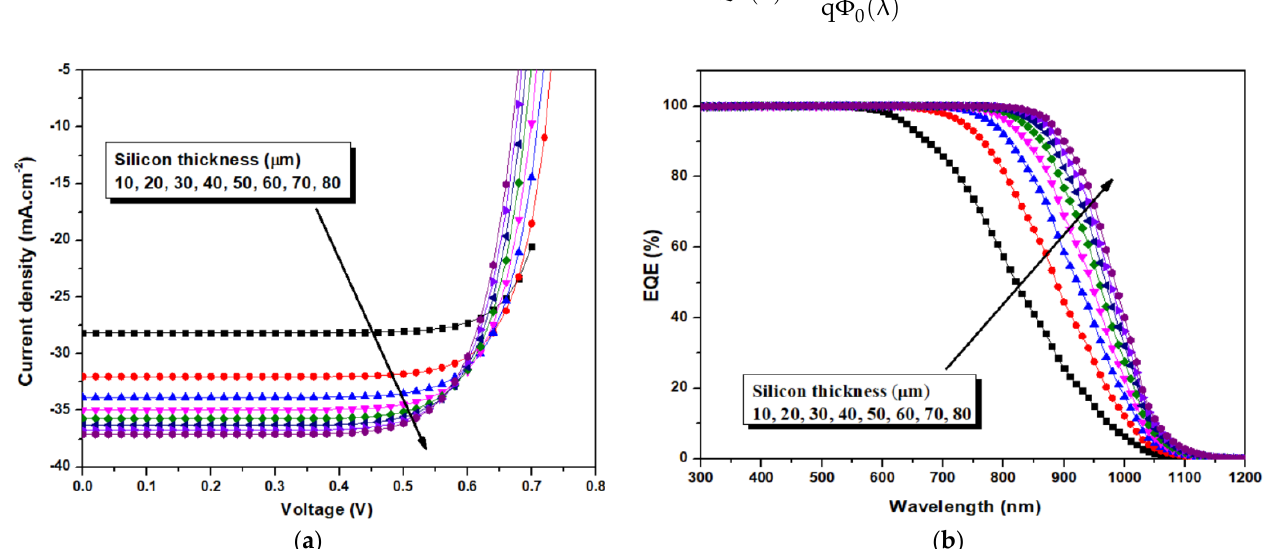
Figure 5. Effect of the n-type silicon layer thickness in standalone conditions on ( a ) the J – V curve ( b ) the external quantum efficiency (EQE).